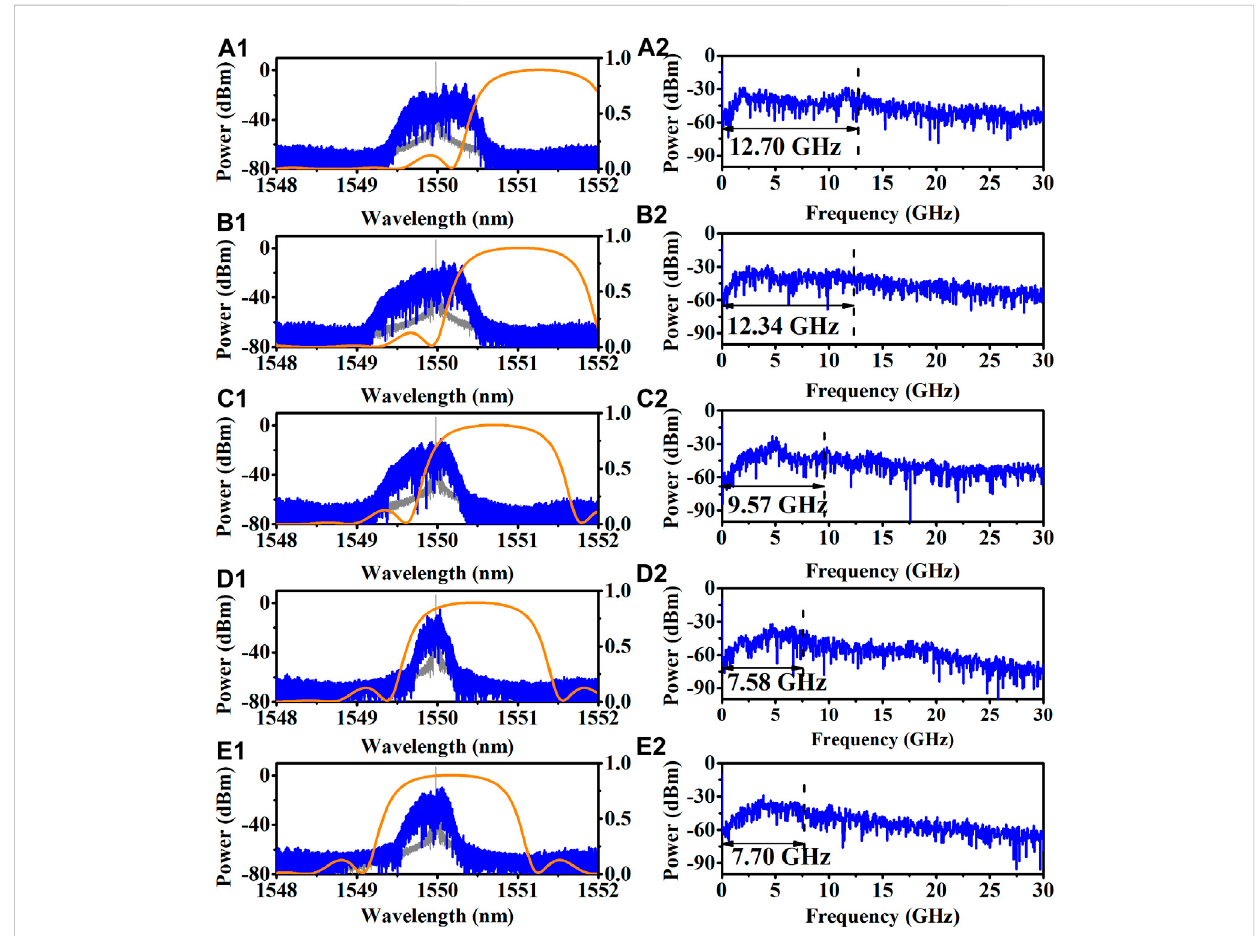
FIGURE 5 Effects of I DBR on laser output characteristics. I DFB = 50.0 mA, I Phase = 16.0 mA; (A) I DBR = 5.0 mA; (B) I DBR = 8.0 mA; (C) I DBR = 12.0 mA; (D) I DBR = 15.0 mA; and (E) I DBR = 19.0 mA.